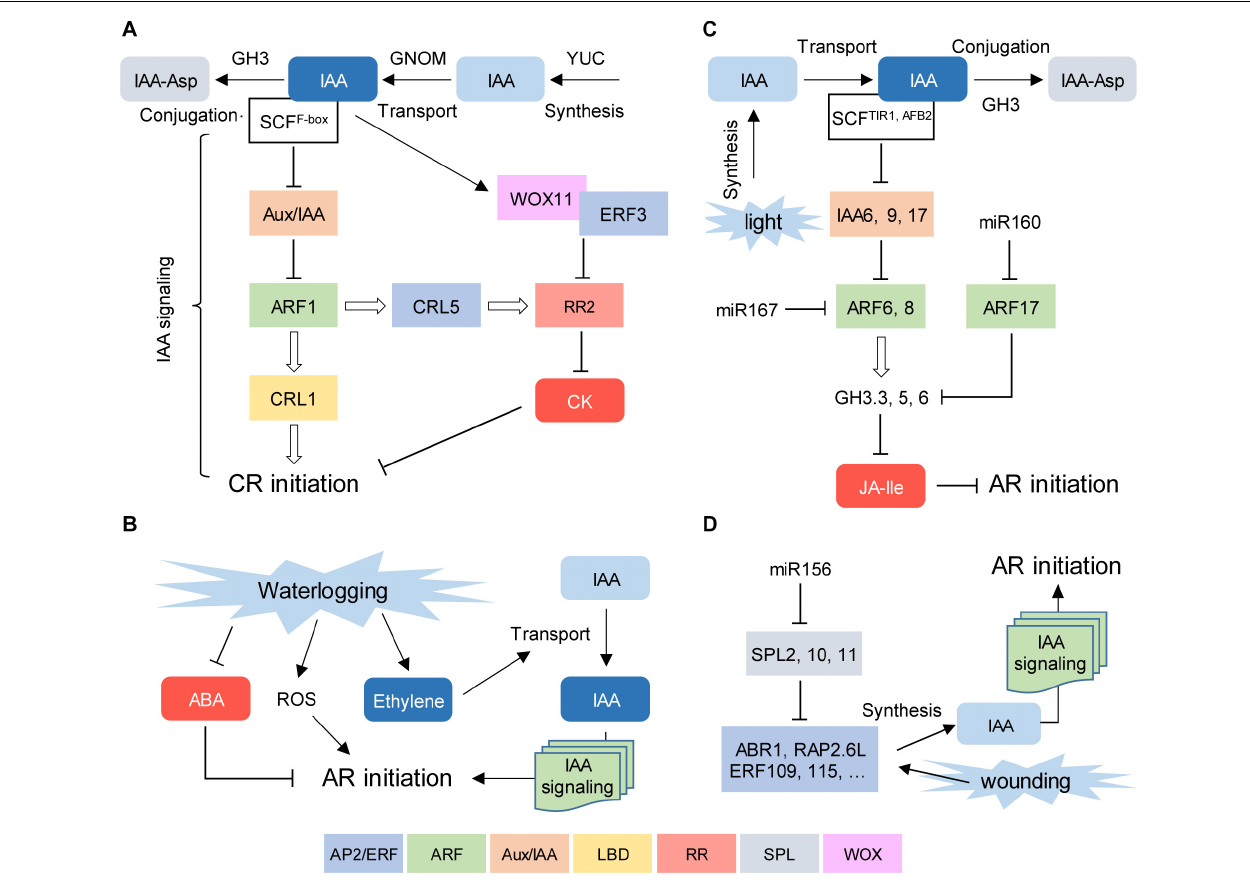
FIGURE 2 | Conserved regulatory pathways for AR formation. (A) Early steps during crown root (CR) formation in rice seedlings. (B) Waterlogging-induced AR formation in bittersweet. (C) Light-stress induced AR formation in Arabidopsis thaliana hypocotyls. (D) Proposed role of miR156 regulation in wound-induced AR formation in A. thaliana leaf explants. Positive and negative hormonal regulators are shown in blue and red, respectively. Transcriptional regulators are depicted inside boxes of different colors. Each color represents a given DNA binding domain (see main text for legends).